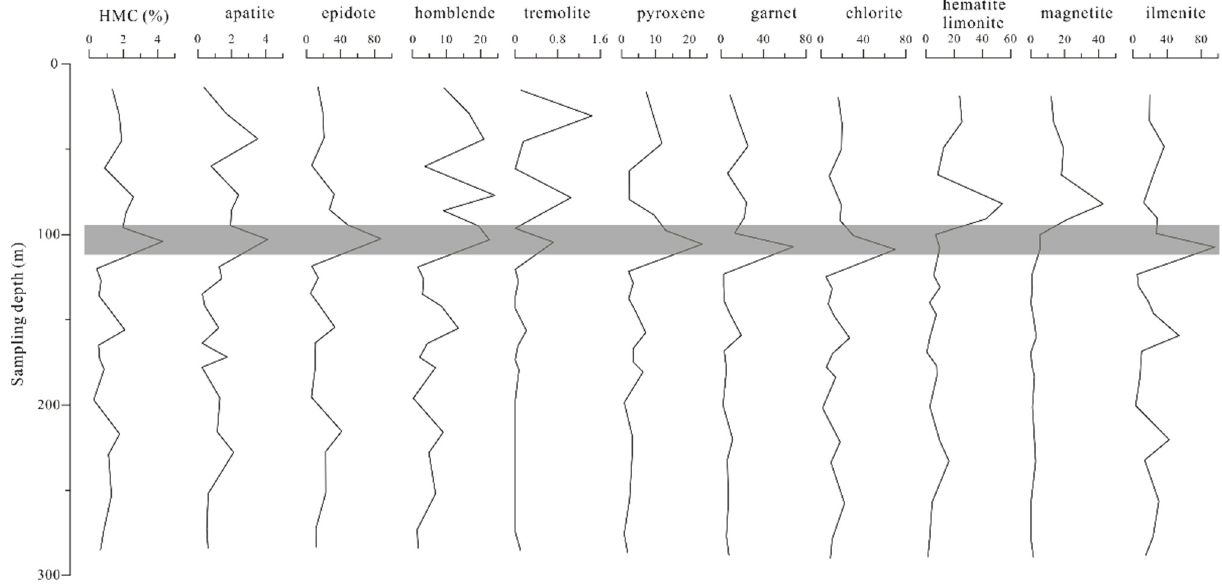
Figure 4. Variation in main heavy mineral contents of the Zhoulao core with depth. The gray rectangle marks where heavy mineral contents show an obvious change at a depth of ~110 m.